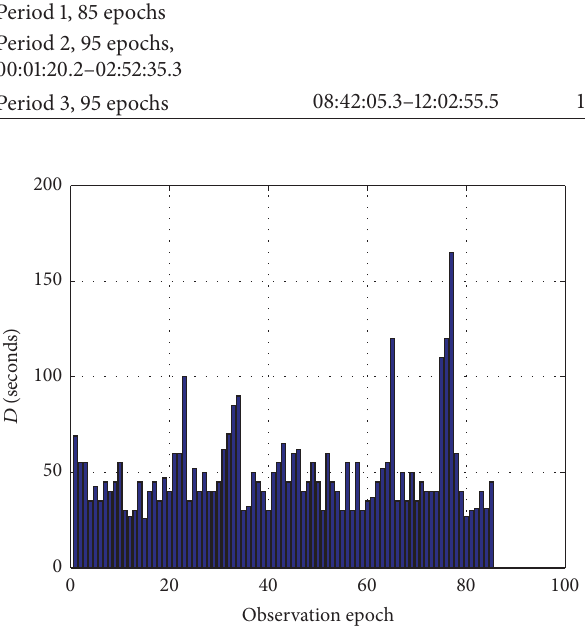
Figure 9: Back-to-back duration using period 3 observation